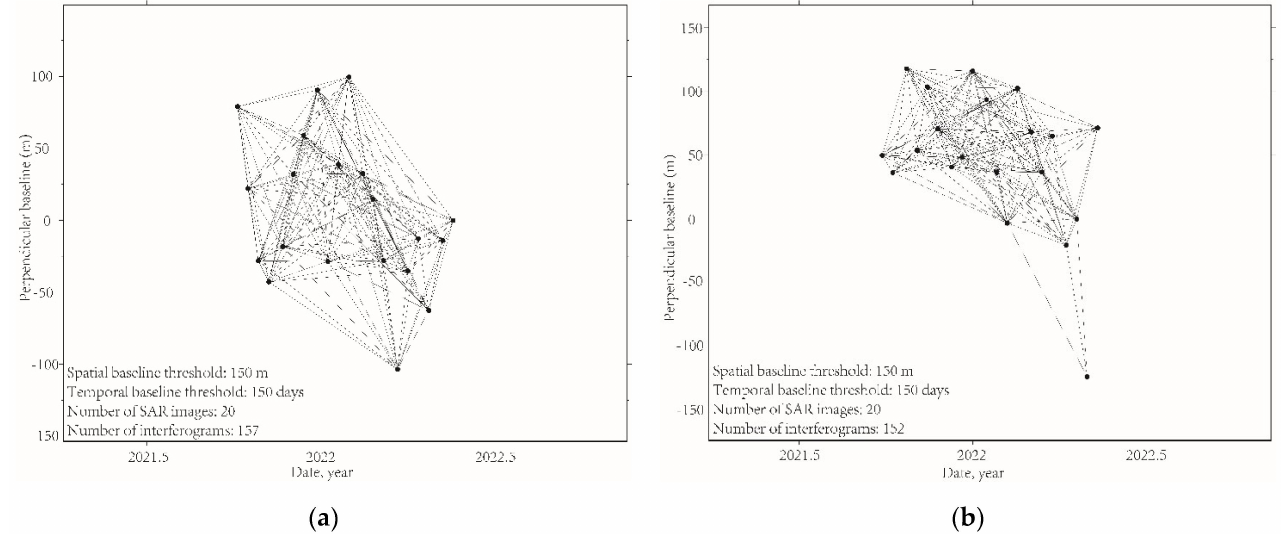
Figure 7. The networks of interferometric combinations for SBAS processing. Note that the 2021.5 and 2022.5 mean the half of a year, not the month of May. ( a ) Ascending track; ( b ) descending